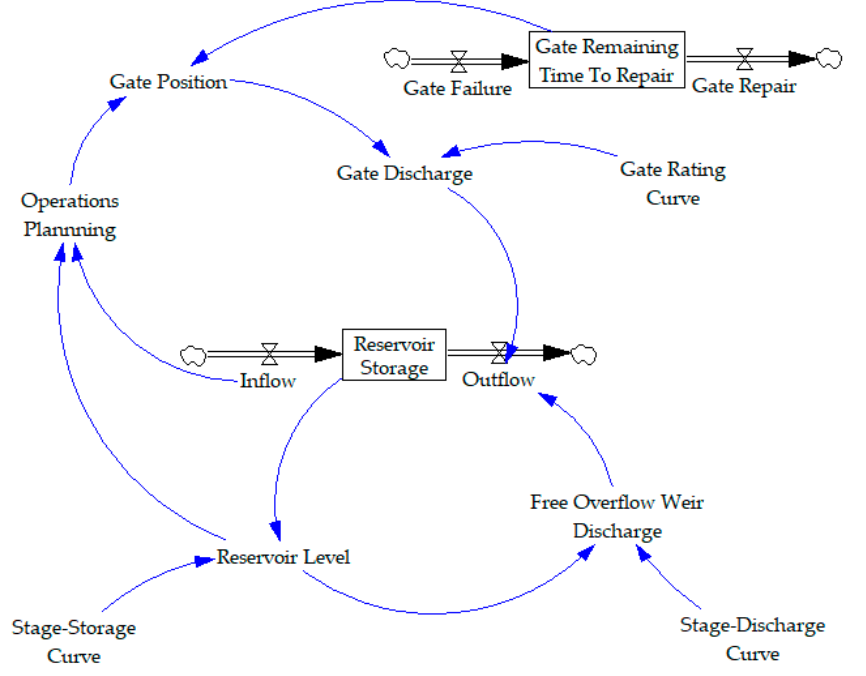
Figure 7. Simple system with gate and weir, with operations planning and gate failures implemented.